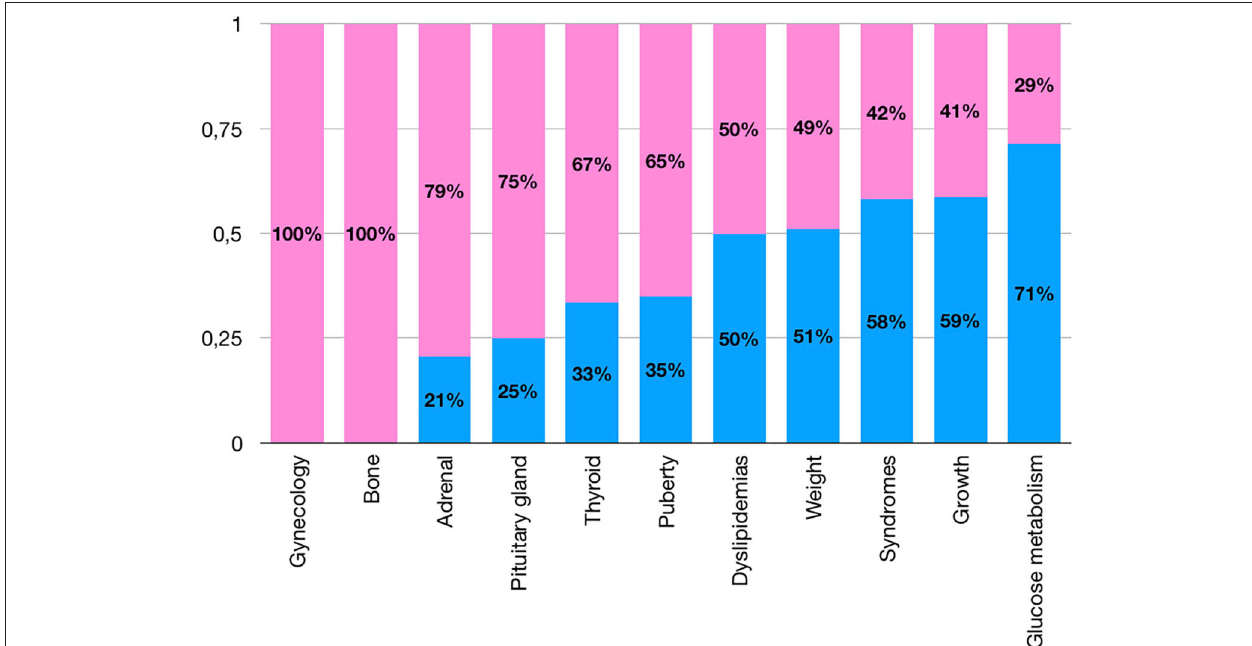
FIGURE 3 | Sex differences in prevalences for cumulative groups of referrals (pink: females; blue: males).